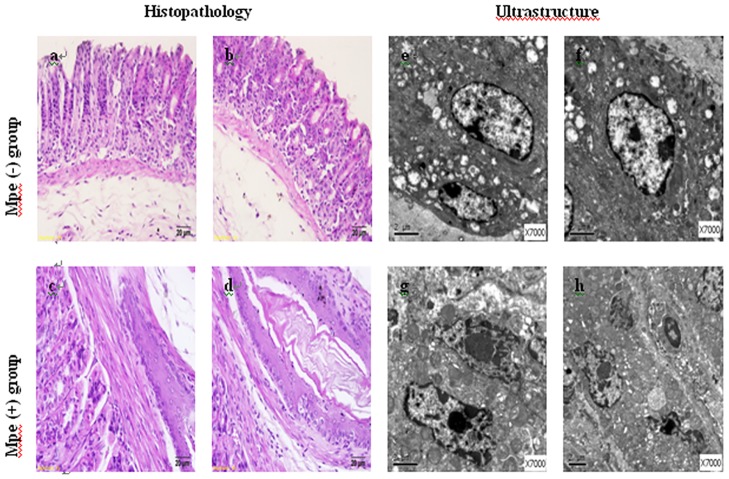
Histopathological and ultrastructure gastric mucosa changes in Mpe infected mice.a and b HE staining of gastric mucosa tissue sections of Mpe non-infected mice groups (pure water and ammonia water sub-group, respectively); c and d HE staining of Mpe infected mice sub-groups (pure water and ammonia water sub-groups, respectively); e and f ultrastructure of gastric mucosa of Mpe non-infected mice groups (pure water and ammonia water sub-group, respectively); g and h ultrastructure of gastric mucosa of Mpe infected mice sub-groups (pure water and ammonia water sub-groups, respectively). Data is representative of three independent experiments (n = 3).